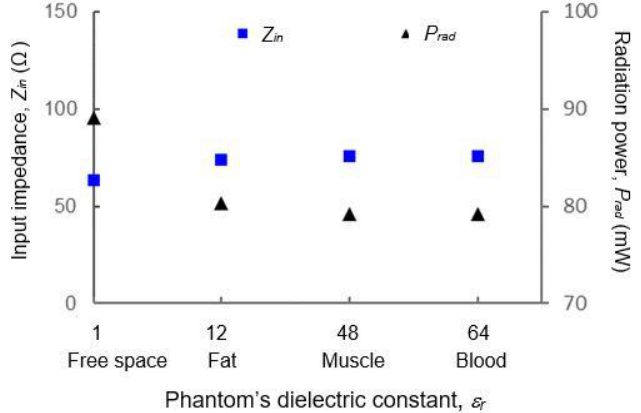
Figure 13. Input impedance and radiated power of the antenna when located near phantoms of various ε r . It shows that Z in is highly affected by the lossy medium, which has resulted in degradation of efficiency due to lower P rad .